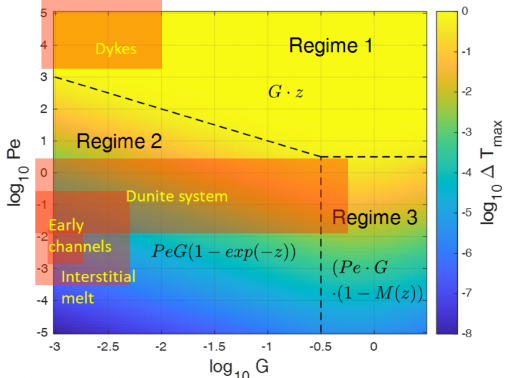
Figure 4. Main regimes of the maximum fluid–solid temperature differences (cid:49)T max due to thermal non-equilibrium obtained by the analytical solution (Eq. 22) in the parameter space of the Péclet number Pe and temperature gradient G . The asymptotic limits are indicated by the formulas, and M(z) is given by Eq. (27) with ( 1 − M (G,z)) increasing non-linearly from about 0 to about 0.4 with increasing z for G in the range 0.3 to 3. Regime boundaries are shown as dashed lines. Typical parameter combinations for mag- matic settings such as interstitial melts or dikes are indicated by the orange rectangles which extend further to the left, well below log 10 G of − 3. Note that two slices through this field at G = 0 . 1 and at Pe = 1 have already been shown in Fig.